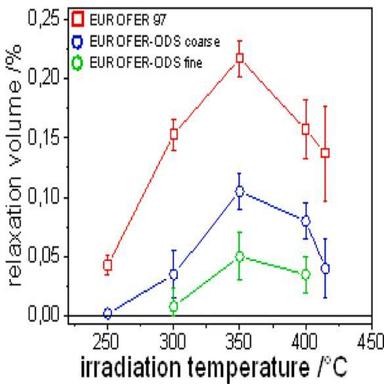
Swelling of ferritic-martensitic steel EUROFER97 and two varieties of ODS steels based on EUROFER 97 exposed to 16.3 dpa and shown as a function of temperature, measured using electron microscope observations of dislocation loops.